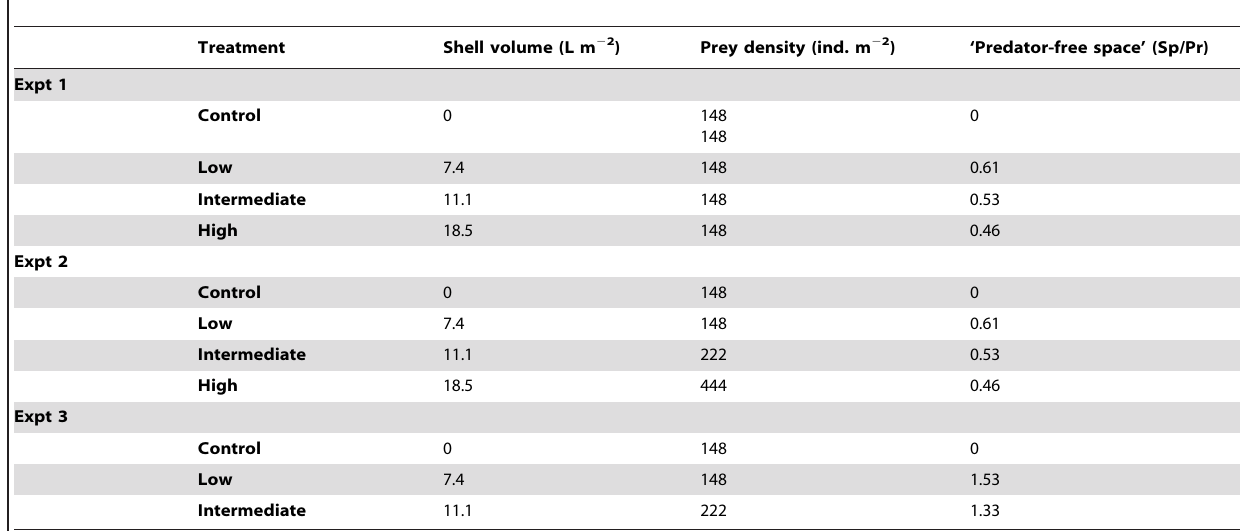
Table 1. Shell volume (L m 2 2 ), prey density (ind. m 2 2 ), and index of ‘predator-free space’ (Sp/Pr) for each experiment by treatment type (n=5).